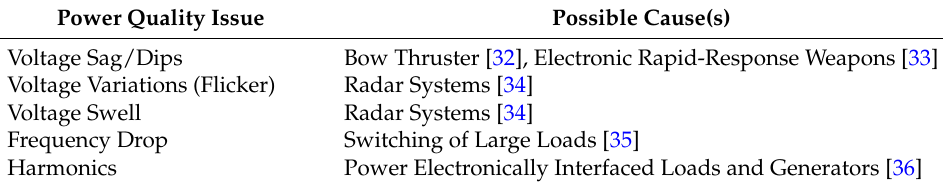
Table 2. Classification of Power Quality Issues in Ship Power System/Microgrid.